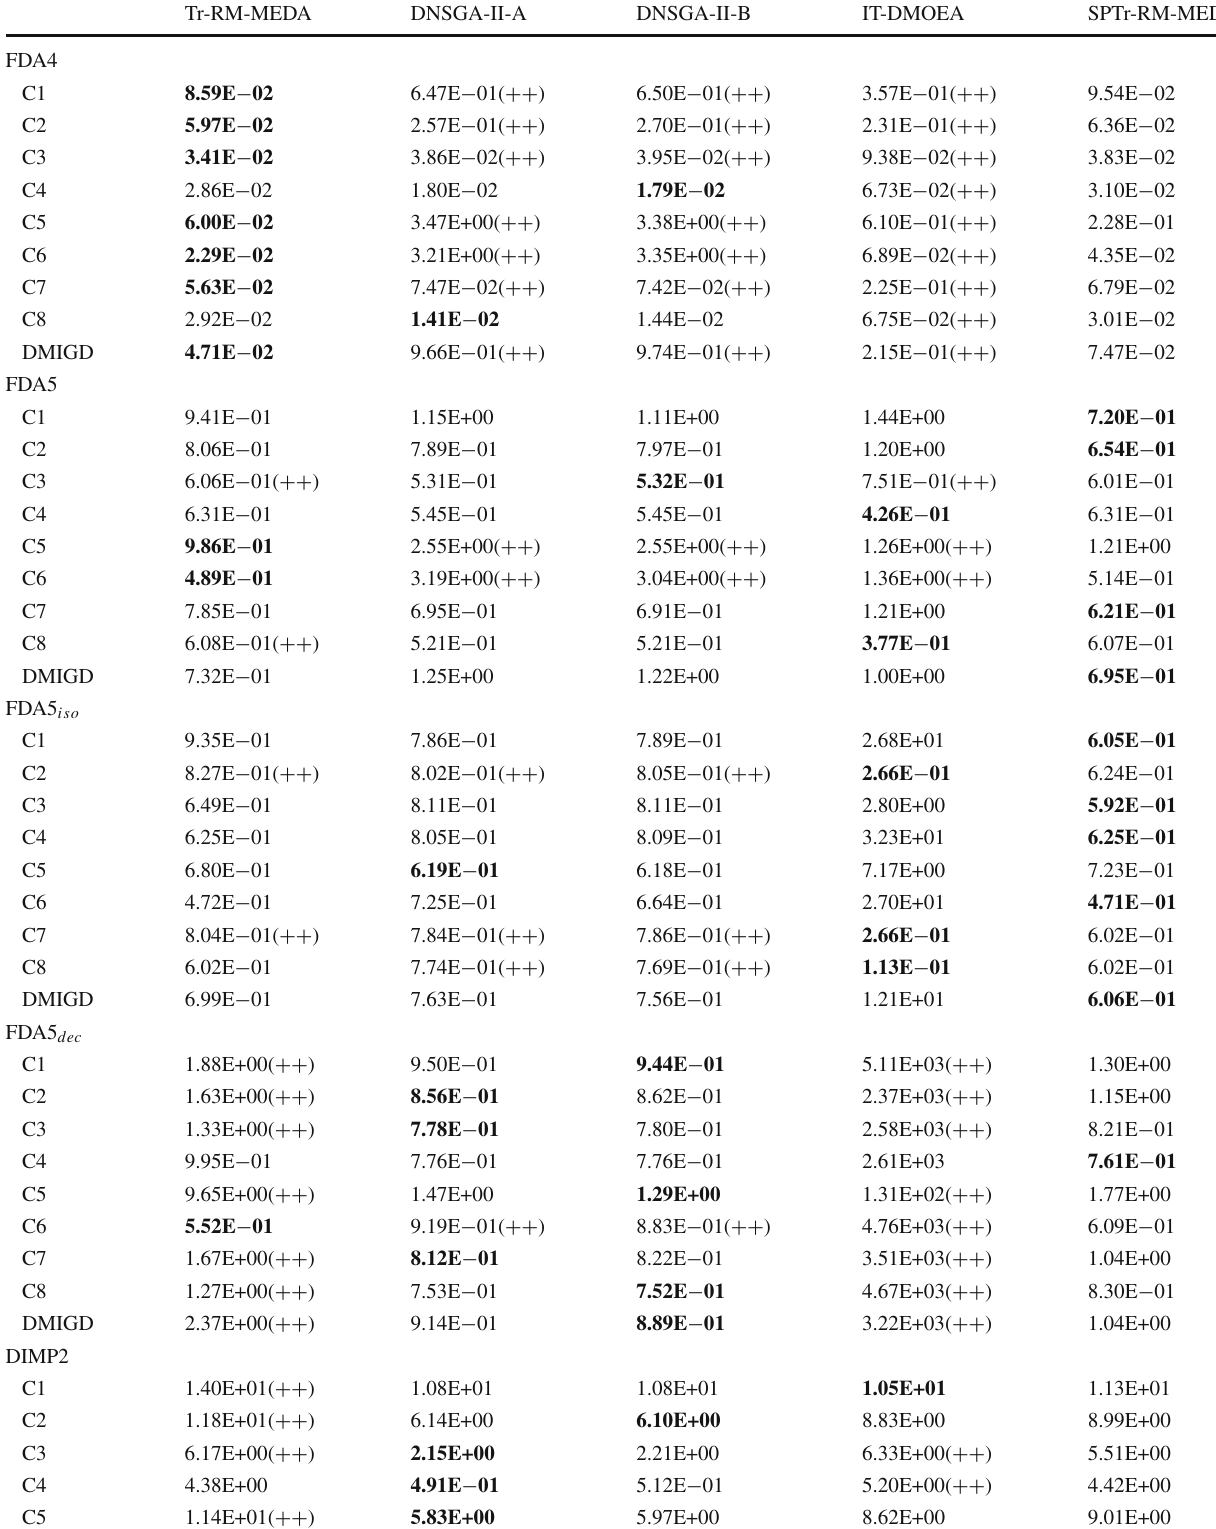
Table 3 The MIGD and DMIGD of 12 test functions compared with four